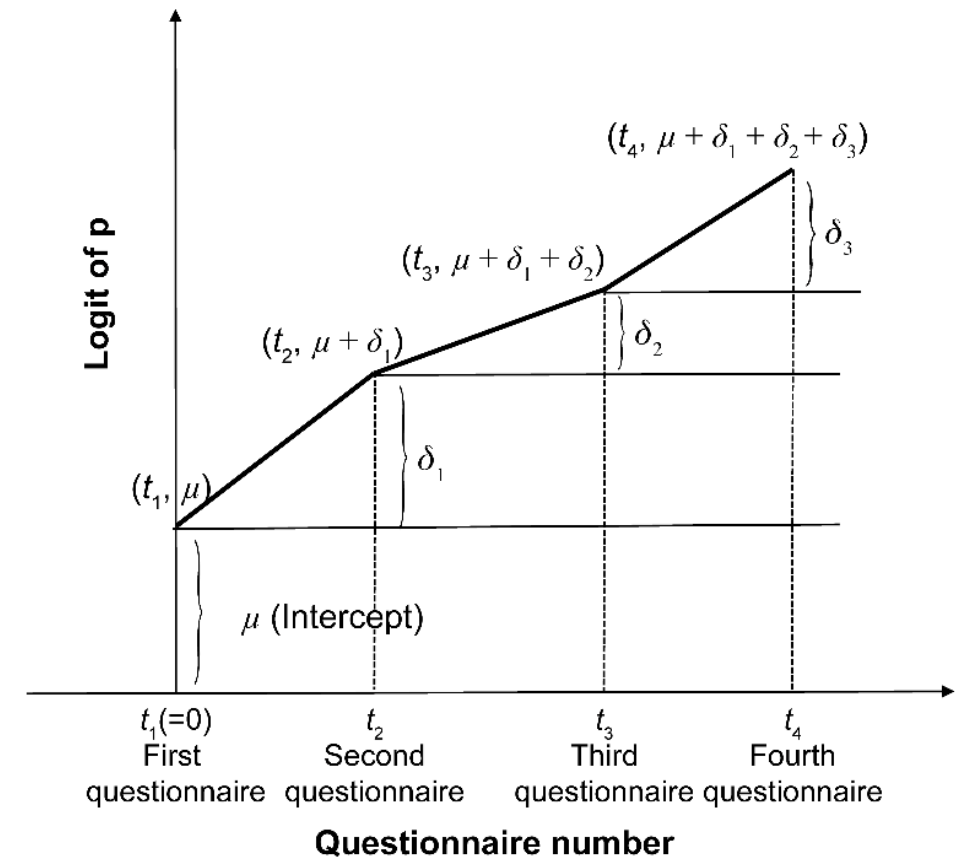
Figure 2. The estimated correct answer rate of the four questionnaires δ . The intercept is the estimated correct answer rate for one observation. From Time 2 onward, the graph was drawn by adding the estimated correct answer rates.